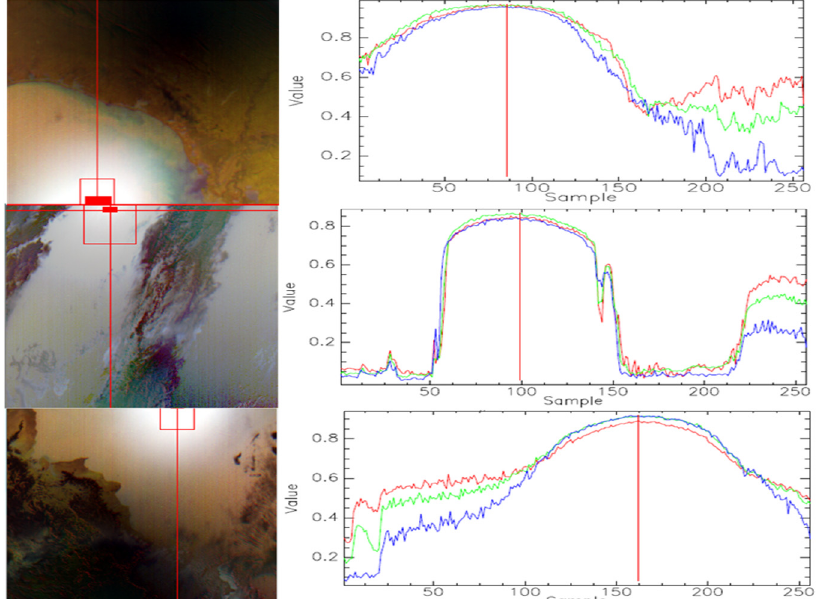
Figure 4. Measured DoLP of the sunlight region. The left image is the color image composited of 565 nm, 670 nm, and 865 nm, and the right image is measured DoLP curve corresponding to the three bands. The Y axis indicates the value of measured DoLP , while the X axis presents the number of samples corresponding to the red line in the left figure. The data are from MAI/TG.